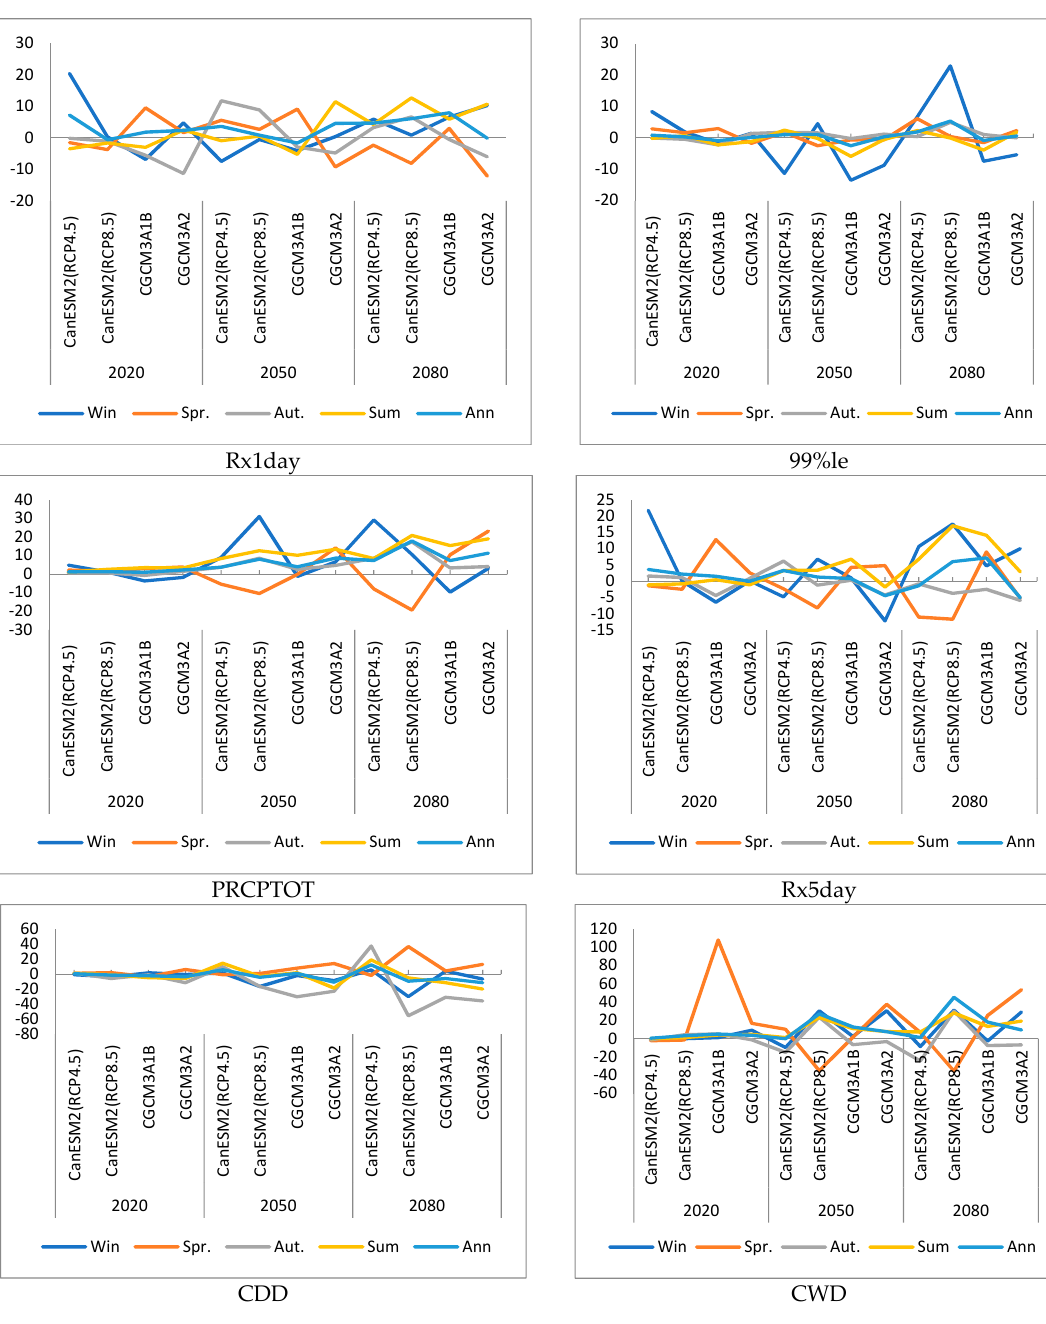
Figure 7. Selected precipitation indices in percentages.